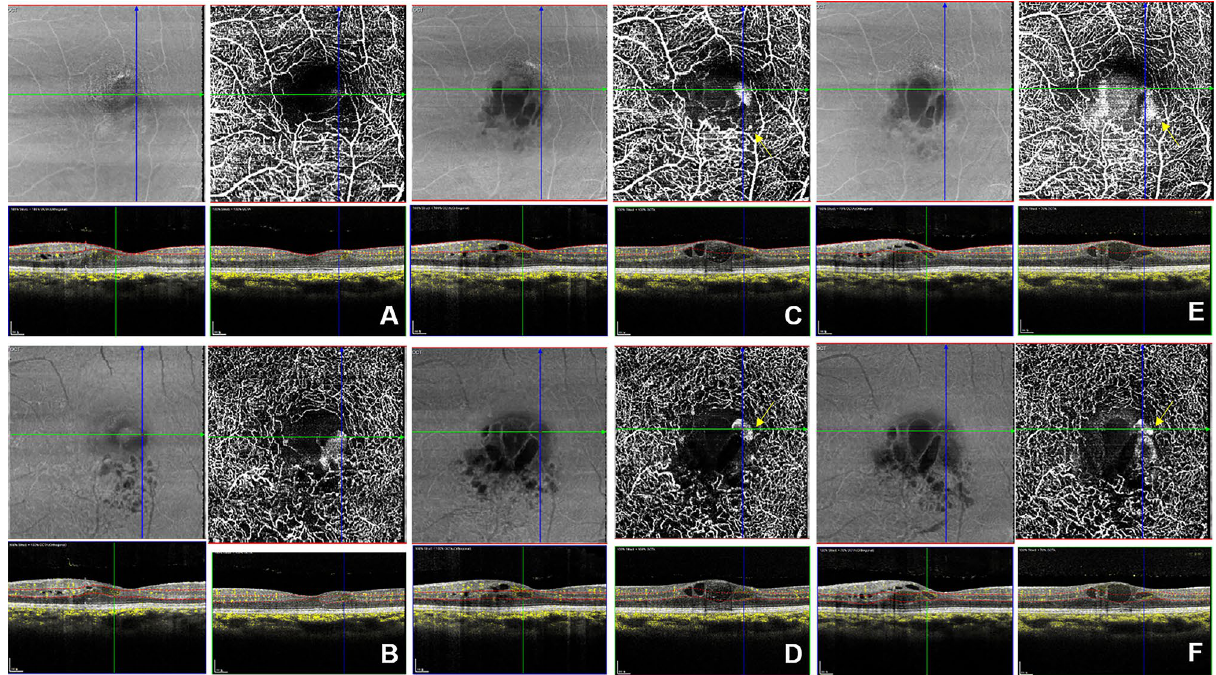
Figure 1. Sequential images of a case with a previous single injection and 5 month disease duration. During 12 months of follow-up, visual acuity remained better than 0.1 logMAR. ( A , B , C , D , E , F ) En face OCTA images (top right), en face OCT image (top left), vertical B-scan images with flow signal (bottom left), horizontal B-scan images with flow signal (bottom right). ( A , C , E ) Images of the SVC (top). ( B , D , F ) Images of the DVC (top). ( A , B ) SSPiM was first observed in both the SVC and DVC. ( C , D ) Three months later, images showed an increased area of SSPiM in both the SVC and DVC. Microaneurysms were observed near the SSPiM (yellow arrow, top right). ( E , F ) Six months later, images showed a further increase in area of the SSPiM in both the SVC and DVC as compared within earlier images ( B ), although there were no interval changes in cyst size between the images shown in ( E ) and ( F ) (bottom left). ( C , D , E , F ) Microaneurysms were also observed near the SSPiM (yellow arrow, top right). Photoshop CC 2017 (Adobe Systems Co, San Jose, CA) was used to create this